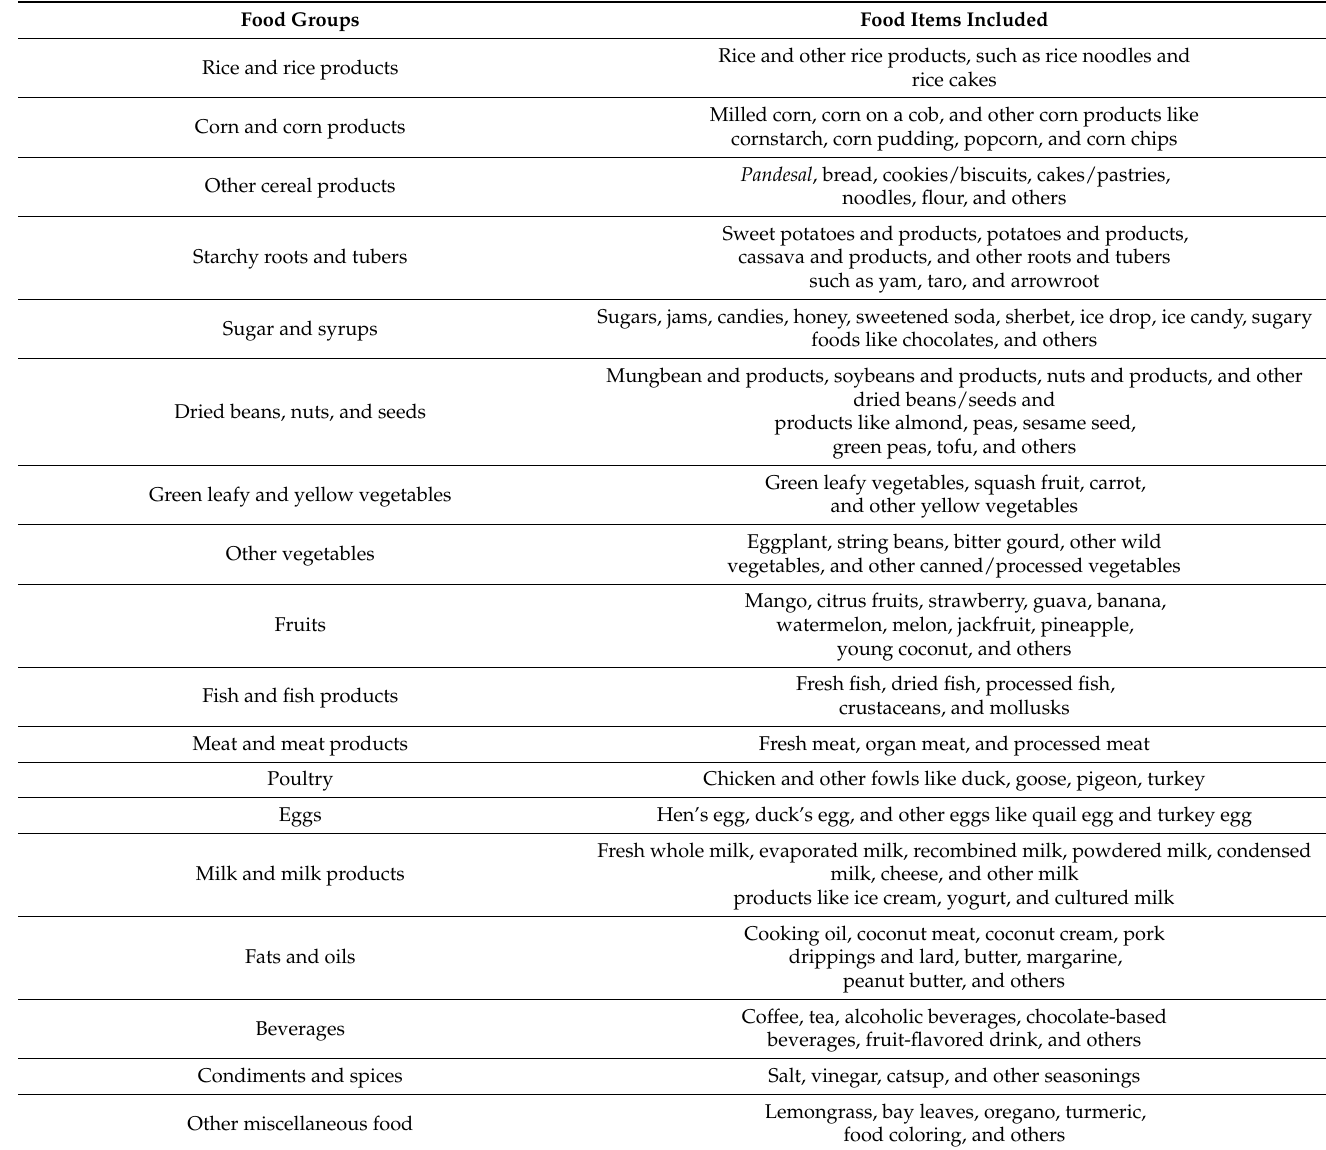
Table 1. Food groups used in the dietary pattern analysis 1